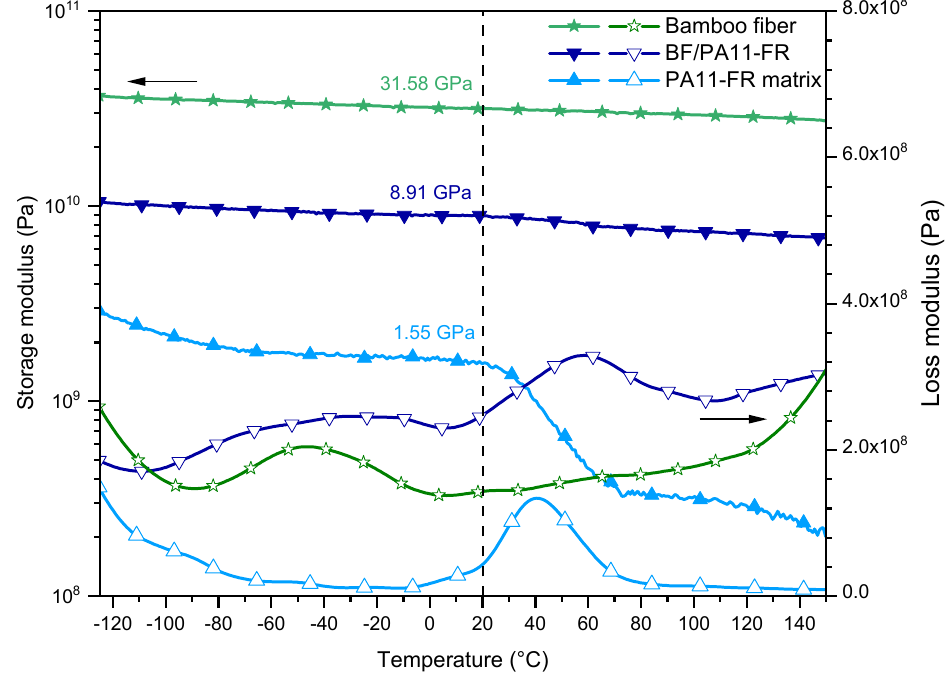
Figure 6. DMA curves in tensile mode of polyamide PA11-FR, bamboo fibers/polyamide PA11-FR composite, and bamboo fiber.